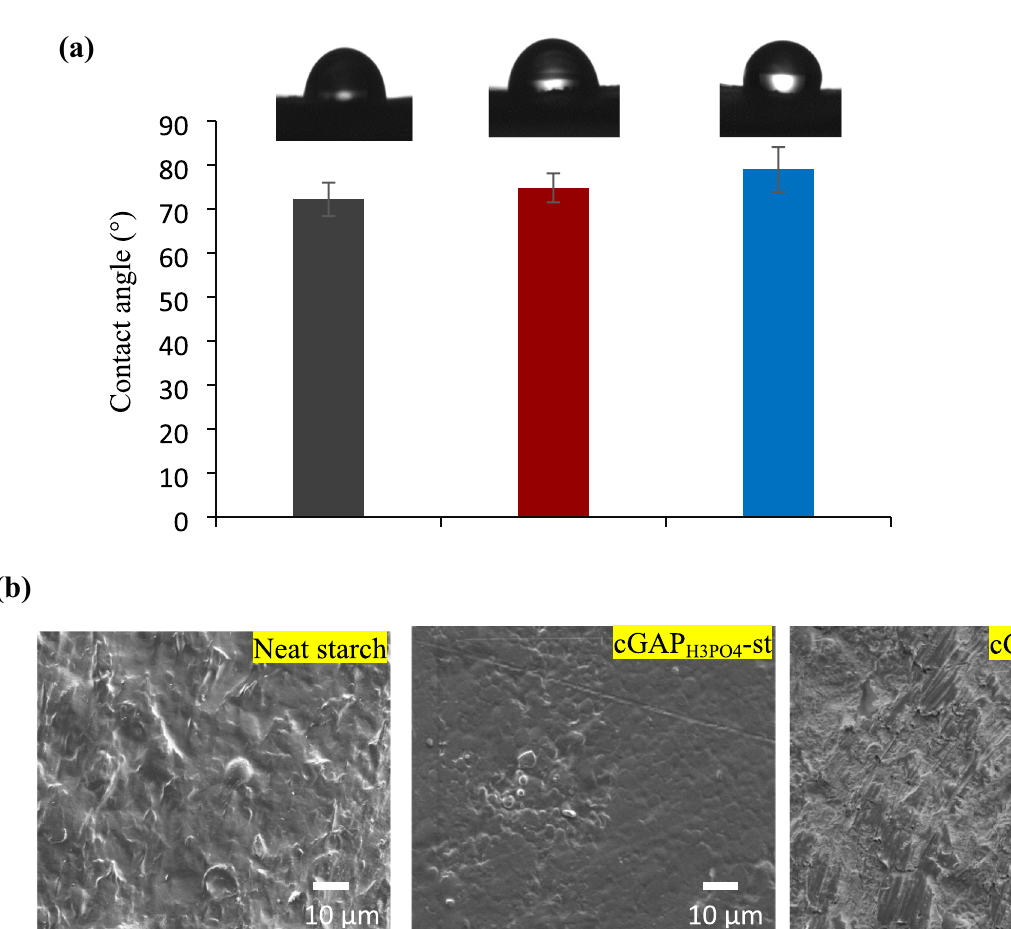
Fig. 3 Photograph of a Contact angle and b SEM micrograph of the neat starch, cGAP H3PO4 -st and cGAP TEMPO -st